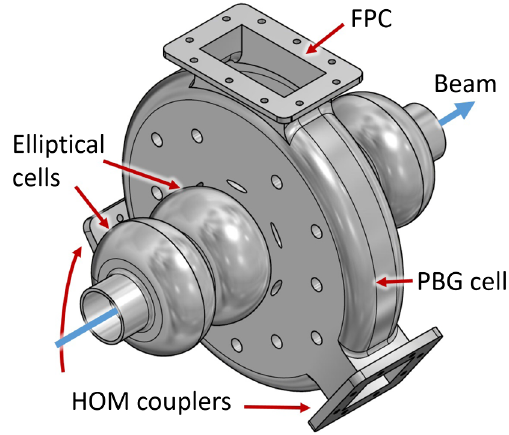
FIG. 2. Drawing of the 2.1 GHz five-cell cavity with the PBG cell replacing one of the elliptical cells.